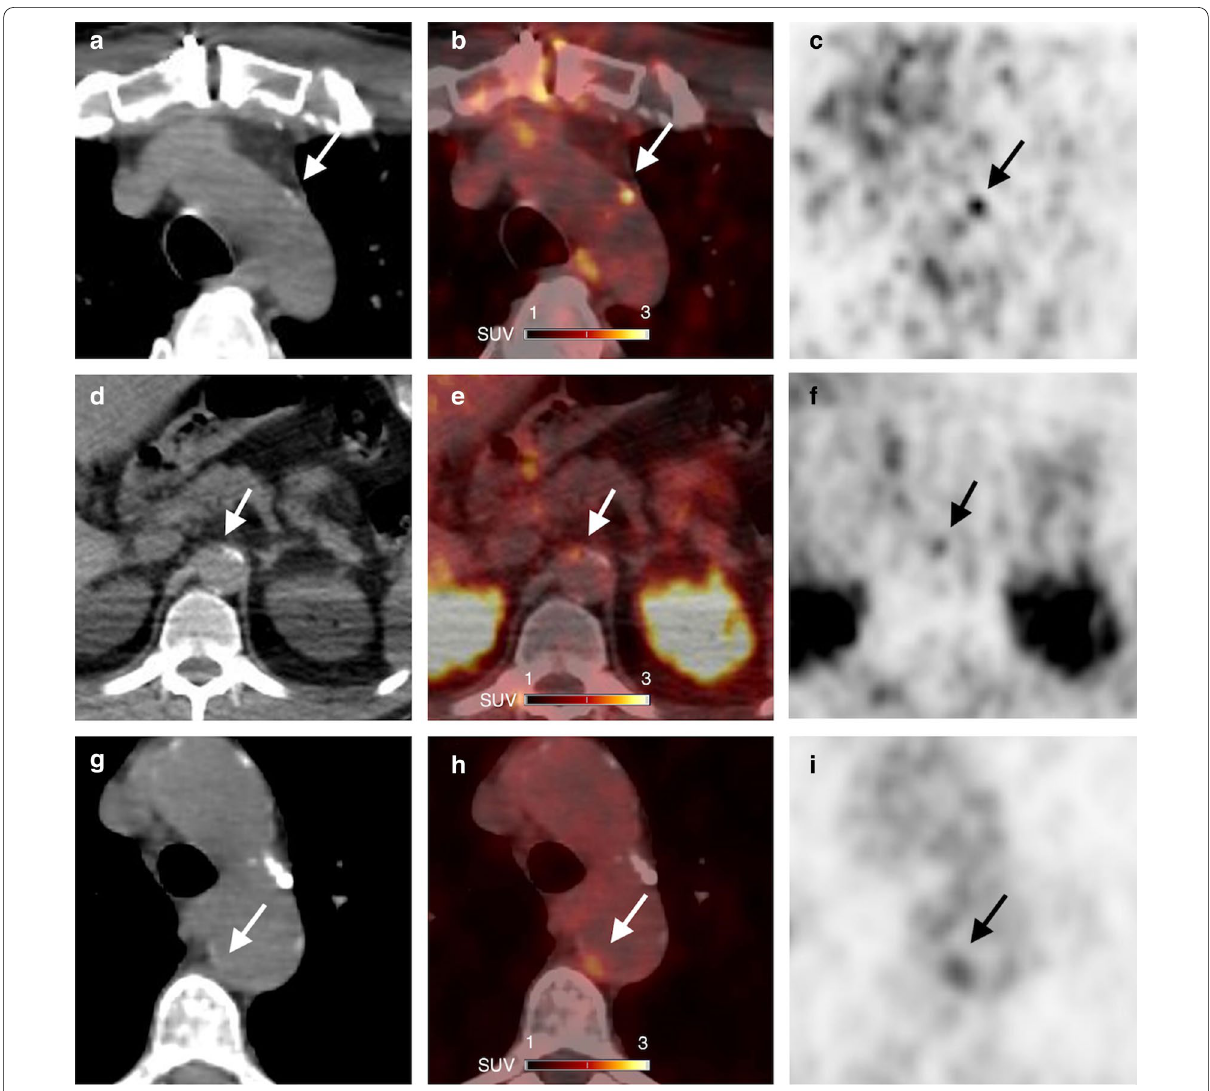
Fig. 2 CT ( A , D , G ), PET/CT ( B , E , H ) and PET images ( C , F , I ) in axial views show foci of 68 Ga-NODAGA-RGD arterial uptake in partly calcified atherosclerotic lesions (arrows): ( A , B , C ) in wall of arch aorta in a 62-year-old man who had a myocardial infarction 5 months before PET imaging; ( D , E , F ) in wall of abdominal aorta in a 54-year-old man who had a transient ischemic attack one week before PET imaging; ( G , H , I ) in wall of arch aorta in a 74-year-old woman who had a myocardial infarction 33 months before PET